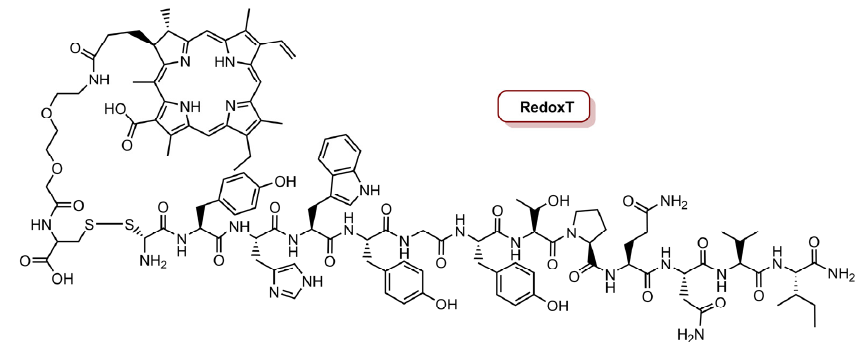
Figure 4. Representation of the structure of redox-responsive specific theranostic (RedoxT) for specific fluorescence imaging and PDT.